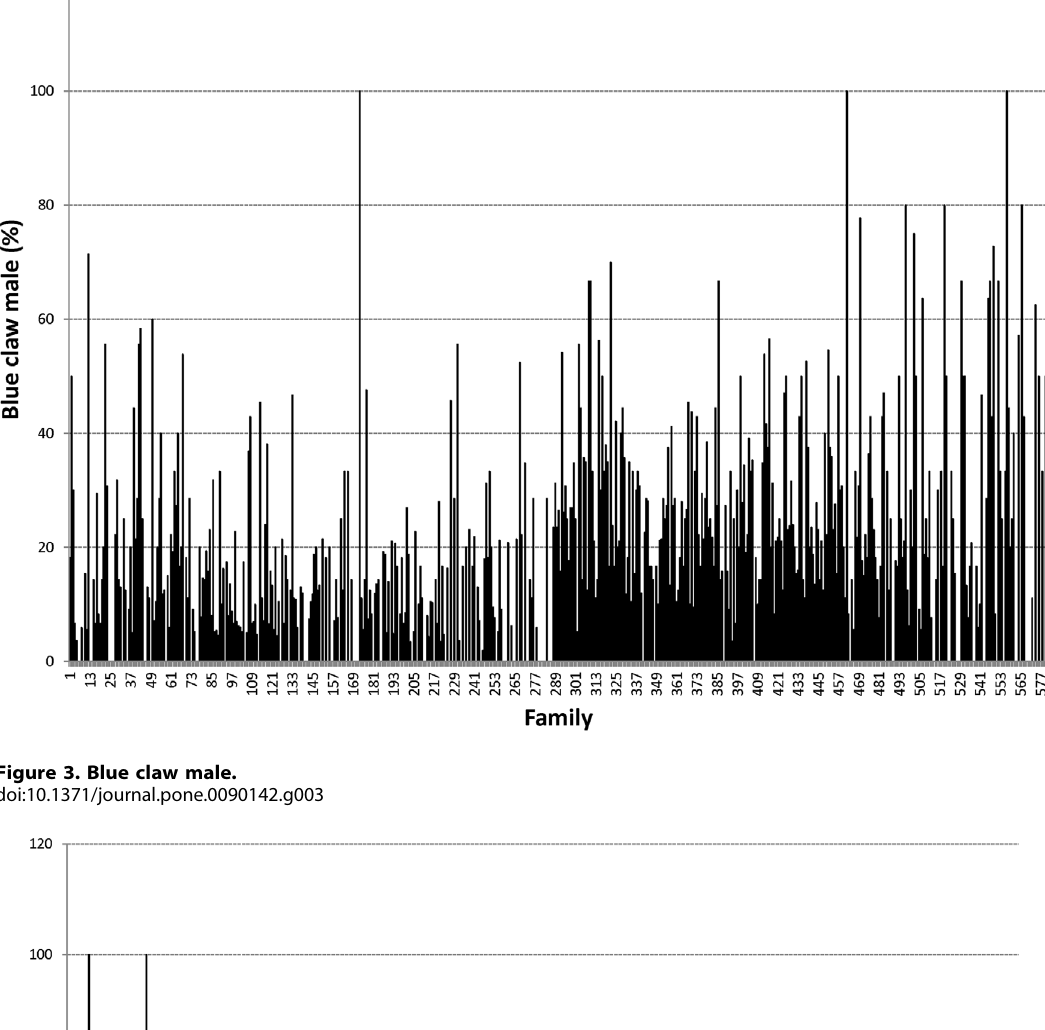
Figure 3. Blue claw male.